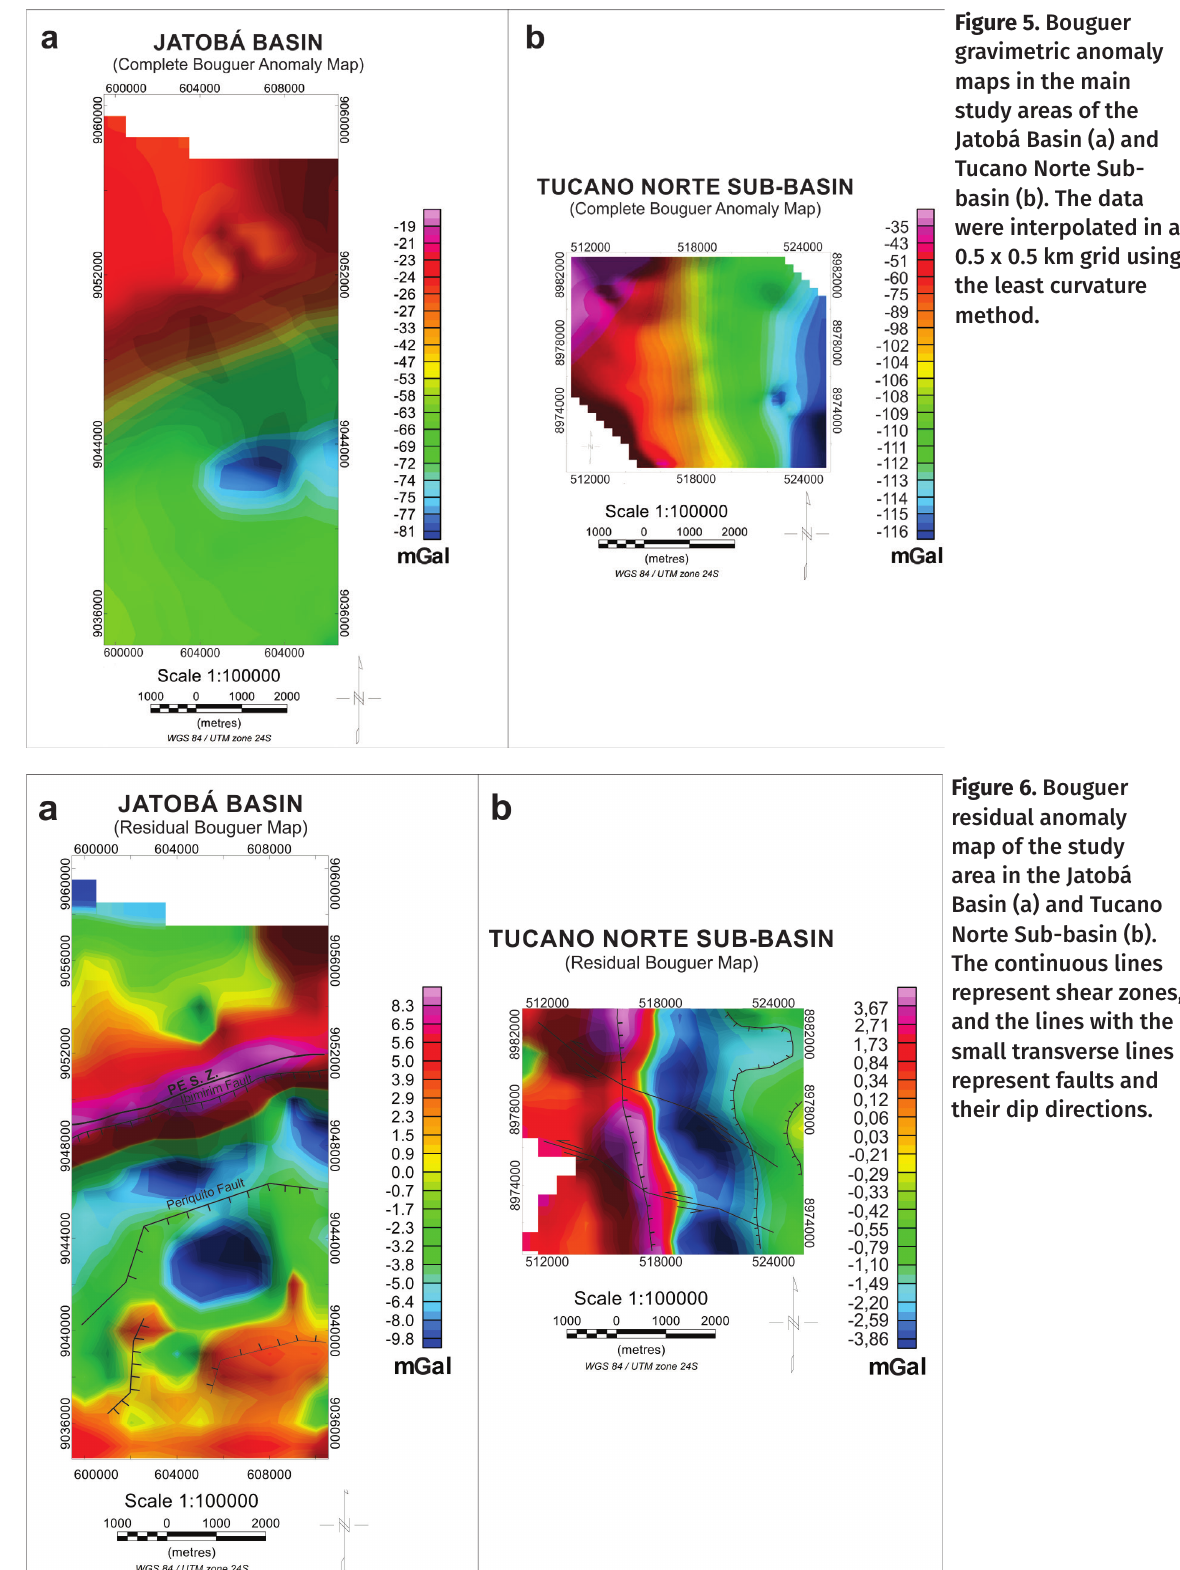
Figure 5. Bouguer gravimetric anomaly maps in the main study areas of the Jatobá Basin (a) and Tucano Norte Sub- basin (b). The data were interpolated in a 0.5 x 0.5 km grid using the least curvature